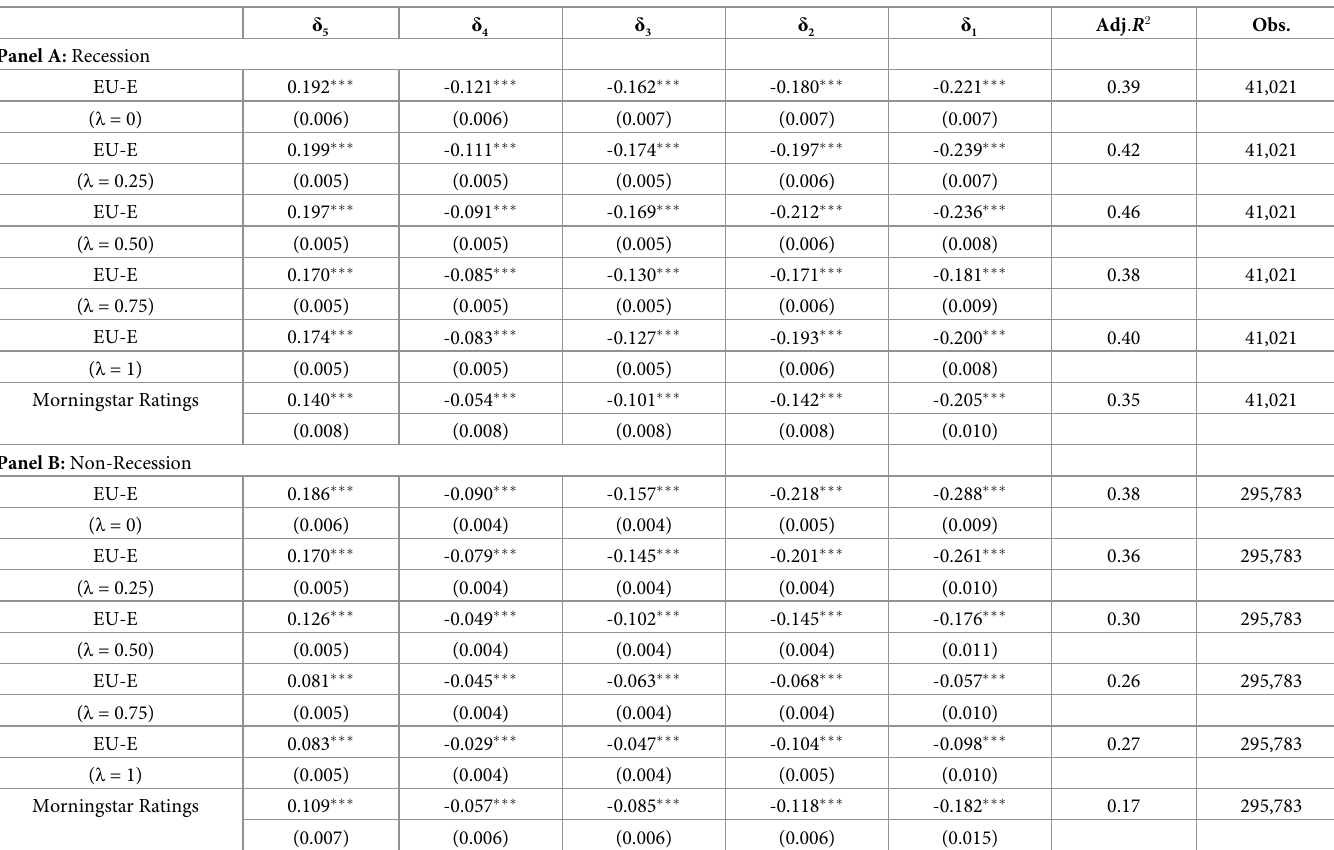
Table 8. Panel regression results across recession sub-samples where the Sharpe ratio measures out-of-sample